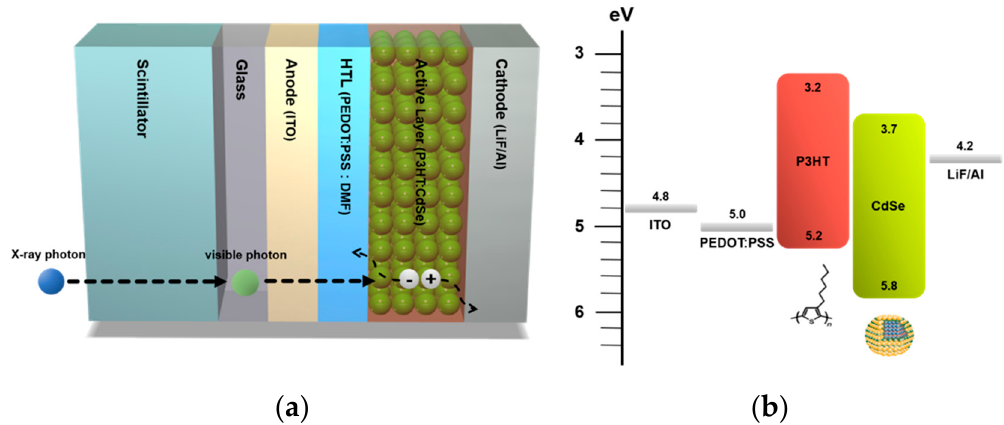
Figure 1. ( a ) Schematic, and ( b ) corresponding energy band diagram of the proposed X-ray detector with P3HT:CdSe active layer.